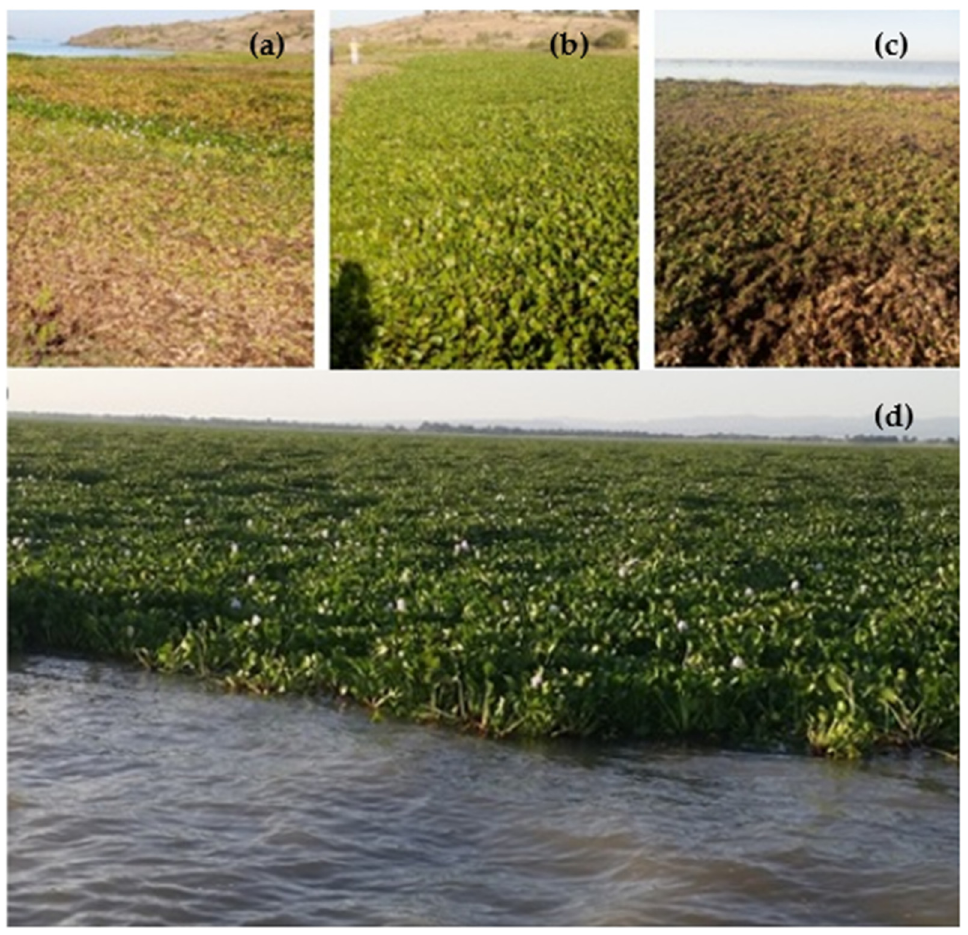
Figure 2. The color change of leaves of water hyacinth in the dry season ( a ), the permanent infestation area in the river mouth in the dry season ( b ), poor disposal on the lake embankment ( c ) and evergreen water hyacinth growth stage ( d ) (Photo by Minychl G. Dersseh, 29 December 2019).